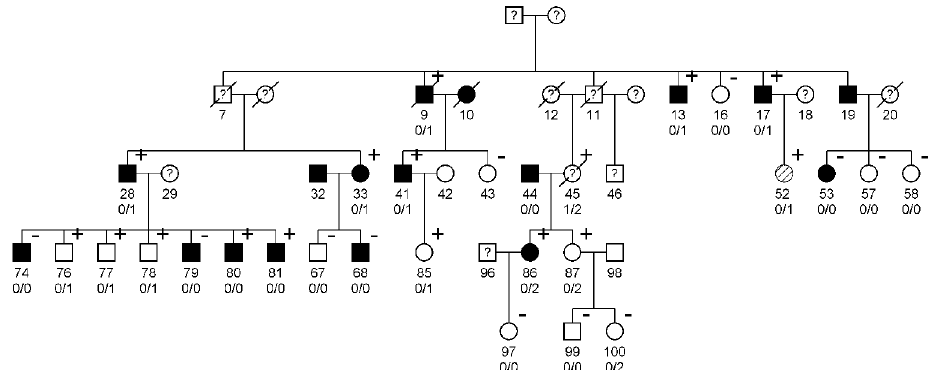
Fig 1. The pedigree of the family with glycosuria. Black symbols indicate that the person has IFG, IGT or T2D (squares = men, circles = females), white symbols indicate normal glucose tolerance. Diagonally hatched symbol indicates T1D (not included in the analysis). Plus and minus indicates positive or negative test for glycosuria. First number under symbols indicates ID number. Genotyping of the deletion (c300-303 +2del) showed that 10 of 22 genotyped family members are heterozygous for the mutation. The carriers of the deletion (c300-303+2del) are denoted with 0/1 and carriers of the reference allele are denoted with 0/0 while carriers of the missense mutation (p.A343V) are denoted with